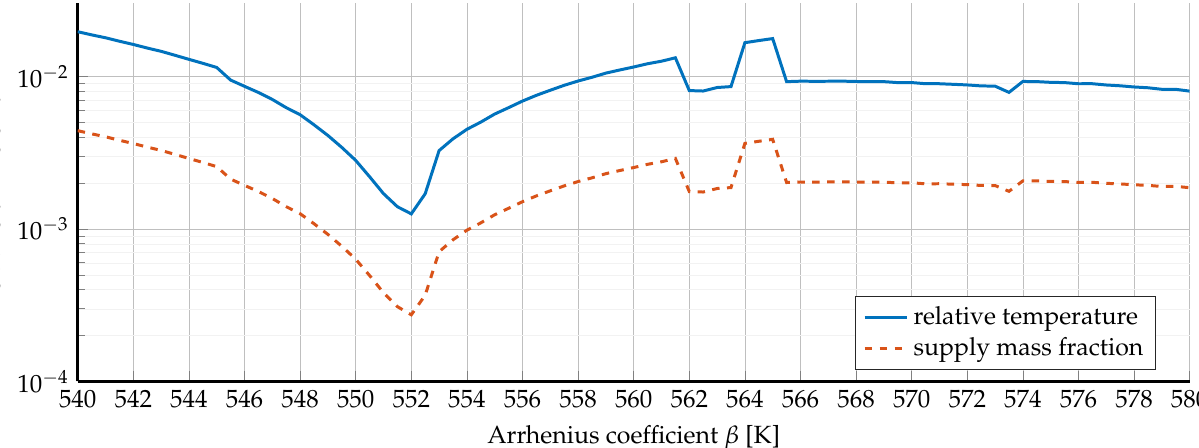
Figure 11. Relative online error of the sPOD-sDEIM ROM with 28 POD modes before switching and 12 transformed modes, four POD modes, and two path variables after switching, trained for β coefficient β ranging from 540K to 580K.